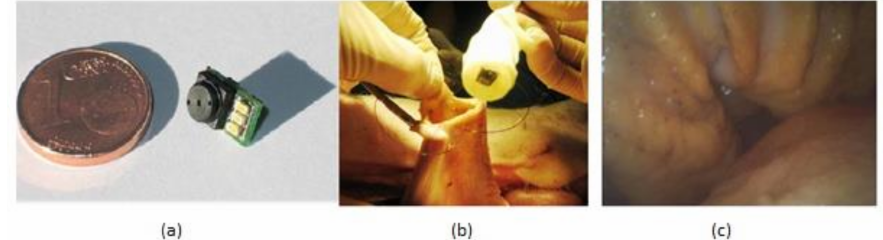
Figure 25. ( a ) Camera module prototype. ( b ) In vivo experiments in pig’s stomach. ( c ) Acquired image of recorded video. Figure adapted with permission from